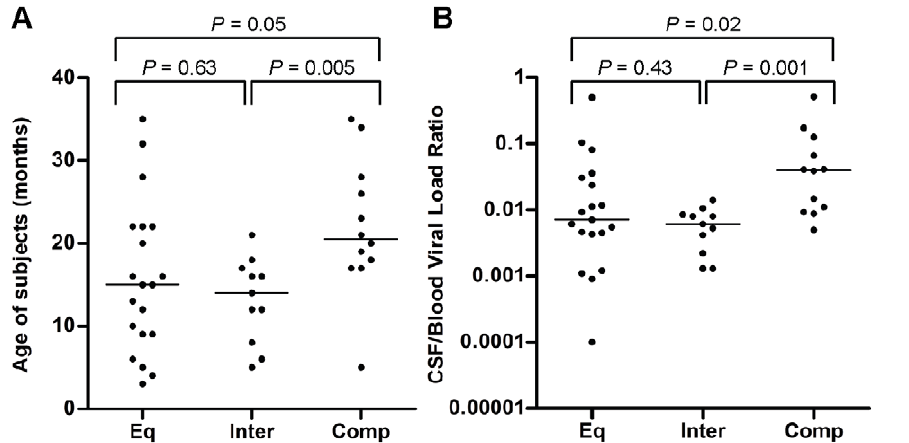
Figure 2. Older age and a higher CSF/blood viral load ratio are strong determining factors for compartmentalization. Relationships between clinical characteristics and genetic compartmentalization were assessed using the Mann-Whitney test in GraphPad Prism 4. Horizontal bars represent median values. A P value , 0.05 was considered statistically significant. (a) Comparisons between age of the subjects and compartmentalization. (b) Comparisons between the CSF/blood viral load ratio of the subjects and compartmentalization.